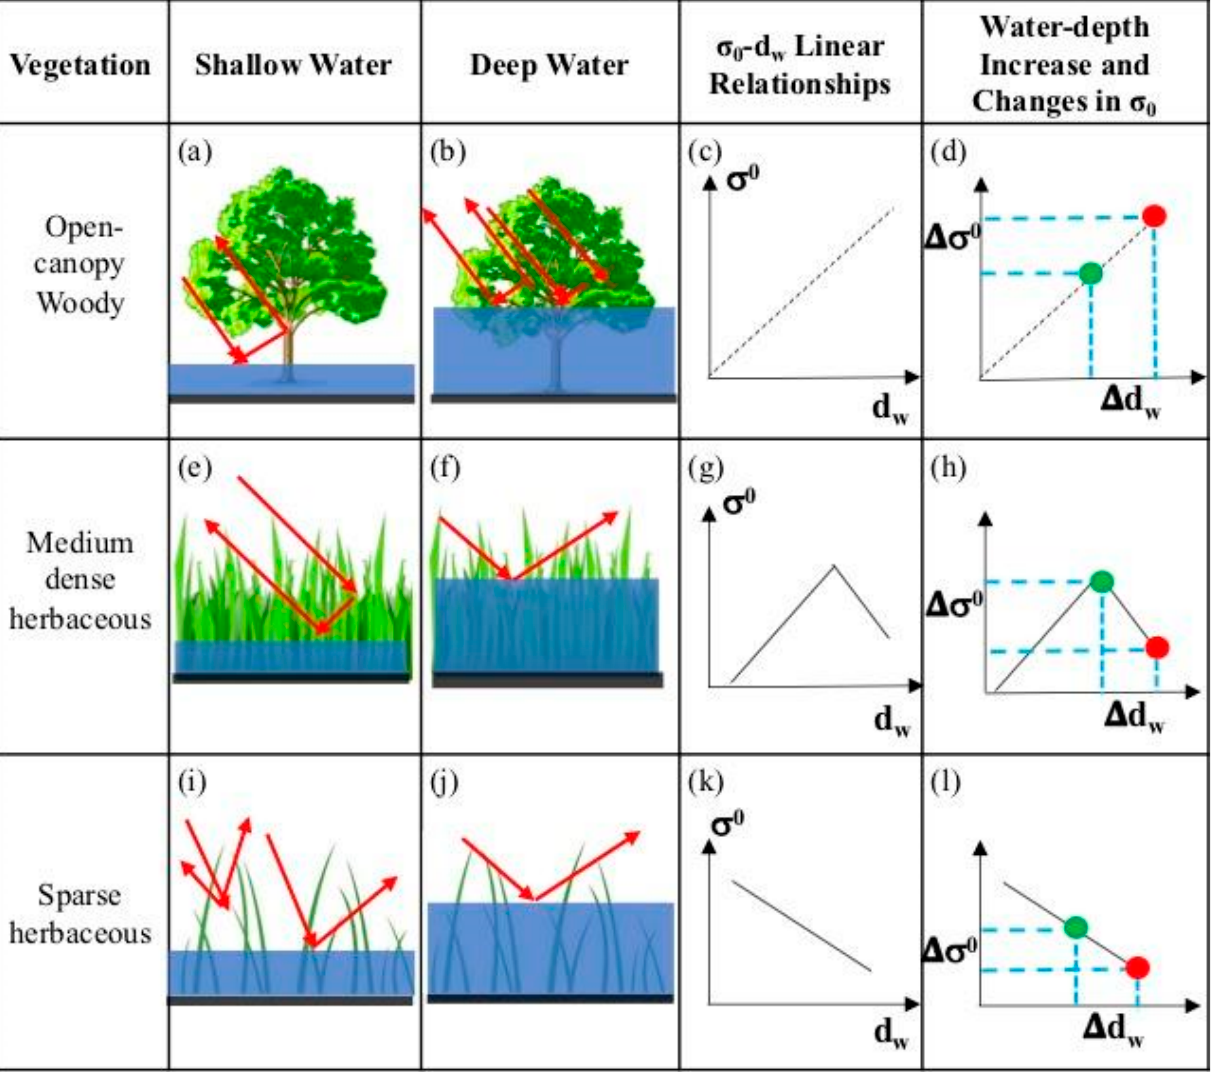
Figure 1. Schematic illustrations showing C-band backscatter ( σ ◦ ) changes in response to water- depth (d w ) variations for three vegetation types. The second ( a,e,i ) and third ( b,f,j ) columns present microwave energy-water-vegetation interactions under the conditions of shallow and deep-water depths, respectively. The fourth column ( c,g,k ) shows linear relationships between co-polarized σ ◦ and d w according to [25]. The dashed line in ( c ) represents a weaker correlation than those in ( g , k ). The last column ( d , h , l ) shows water-depth increases ( ∆ d w ) resulting in changes in backscatter ( ∆ σ ◦ ). The green and red dots in ( d , h , l ) represent pre- and post- rainfall event observations, respectively, and cyan dashed lines show water-depth increases and changes in backscatter. This figure is a modified version of Figure 2 in [25].